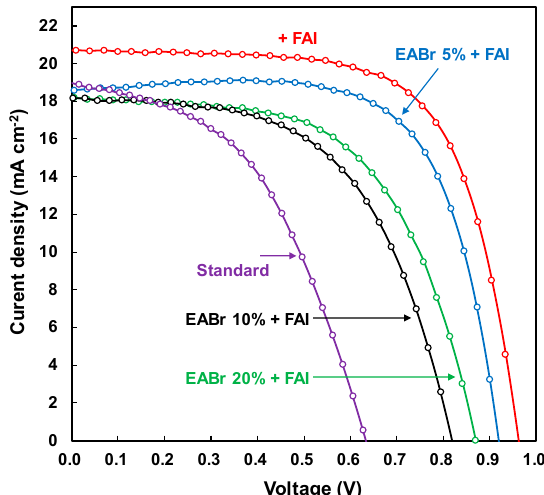
Figure 3. J – V characteristics collected in light condition for the fabricated solar cells after 4 weeks in ambient air without encapsulation. Table 3. Measured photovoltaic parameters of the fabricated cells after 4 weeks.